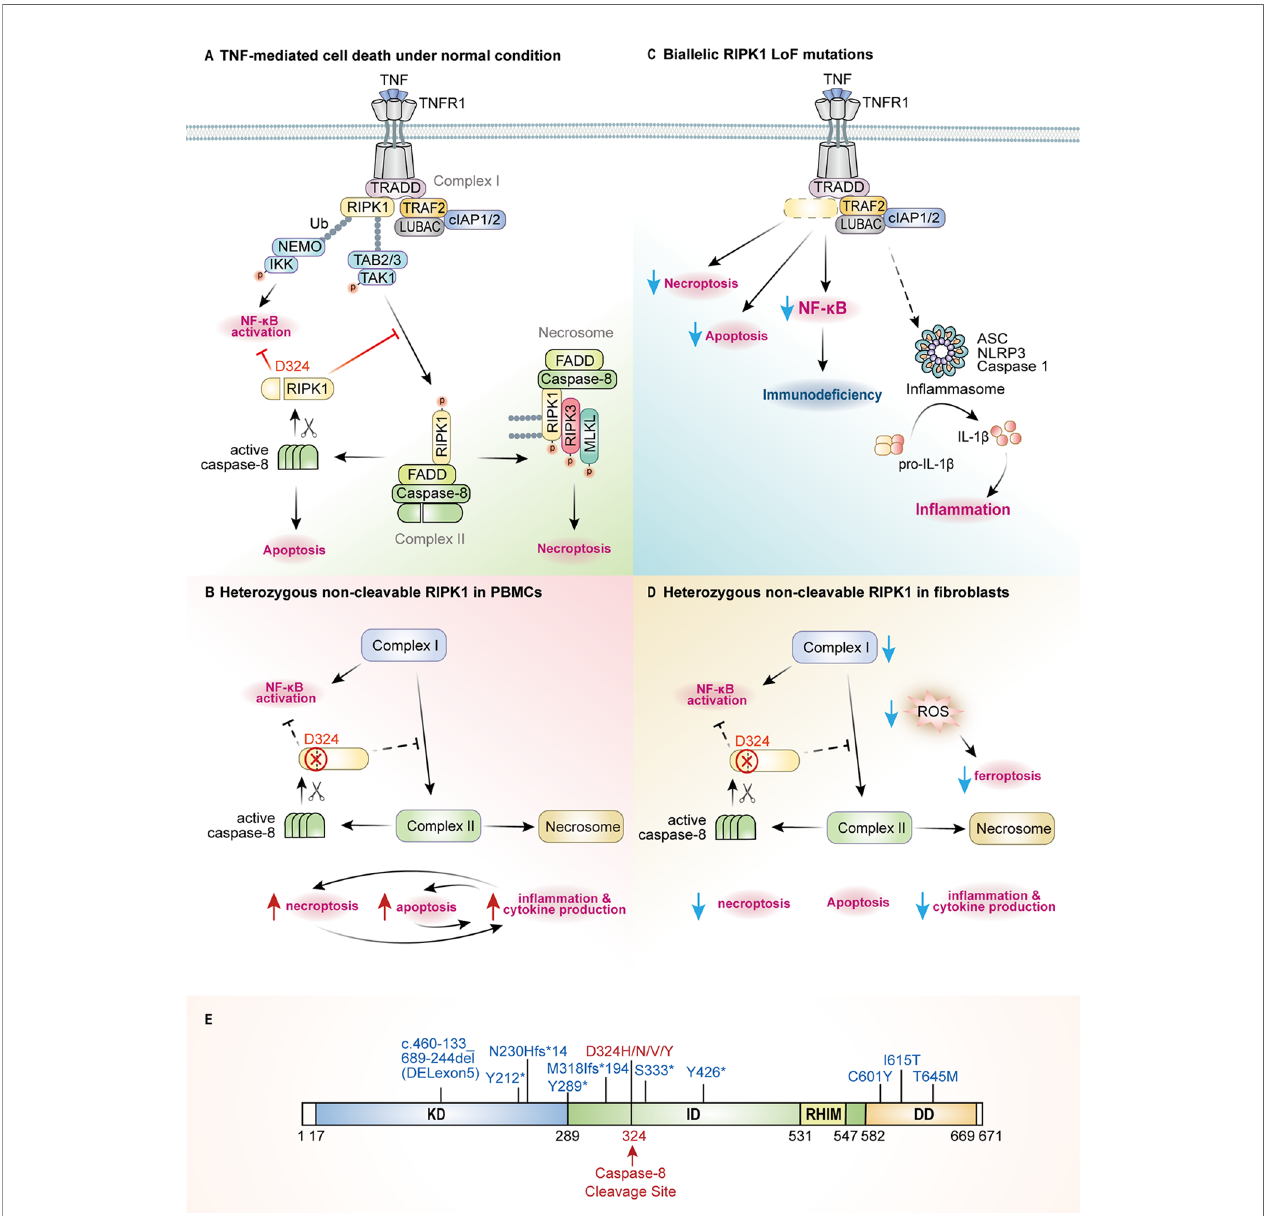
FIGURE 1 | The pathogenic mechanisms of RIPK1-de fi ciency and CRIA patients. (A) RIPK1 is the key switch protein to mediate signal transduction downstream of TNFR1. TNF mediated TNFR1 trimerization results in recruitment of TRADD and RIPK1 through death-domain interactions to form complex I where post translational modi fi cations (PTMs) by E3 ligases such as TRAFs, cIAPs and LUBAC or kinase complexes NEMO/IKK, TAK1/TAB2/3 determine the cell fate either to activate NF- k B signaling or to execute programmed cell death pathways. RIPK1 activates itself through trans -autophosphorylation and then interacts with FADD/caspase-8 to form the complex II to undergo RIPK1-dependent apoptosis (RDA), or it binds RIPK3/MLKL to form the necrosome and to initiate necroptosis. Active caspase-8 can cleave RIPK1 at Asp324 to inhibit complex II formation, and the RIPK1 inactivation will shift the balance towards necroptotic signaling. (B) In PBMCs of CRIA patients, due to the pathogenic mutations at Asp324, RIPK1 activation and all downstream signaling pathways are ampli fi ed to promote in fl ammation and cytokine production. (C) In case of the RIPK1 de fi ciency caused by biallelic LoF mutations, complex I-mediated signaling and downstream events will be blocked, leading to decreased NF- k B activation and impaired cell death. However, de fi ciency of RIPK1 may promote noncanonical TLR4-TRIF-RIPK1-FADD-Caspase-8 signaling to activate in fl ammasome formation and necroptosis. (D) Non-cleavable RIPK1 in CRIA patients fi broblasts causes reduced in fl ammatory signaling and necroptosis, but almost unchanged levels of apoptosis under TNFR1 signaling pathway. Besides, the decreased production of ROS in fi broblasts through yet unknown mechanisms leads to reduced ferroptosis. (E) The position of RIPK1 (NM0038.4.6) LoF mutations (blue, homozygous) and cleavage-de fi cient mutations (red, heterozygous) are indicated across the protein